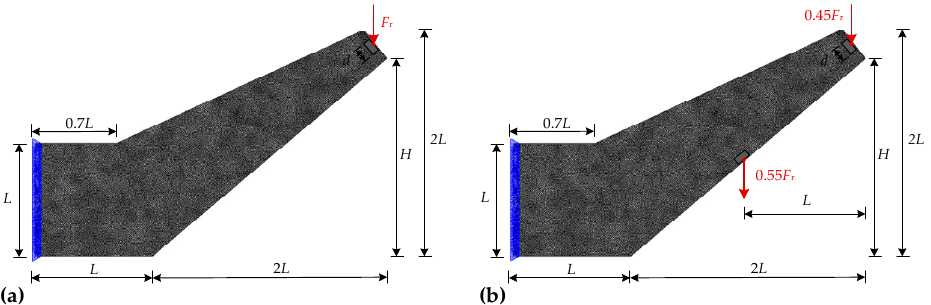
Figure 9. Design domain and boundary conditions for an antenna bracket: ( a ) single load, ( b ) multiple loads.